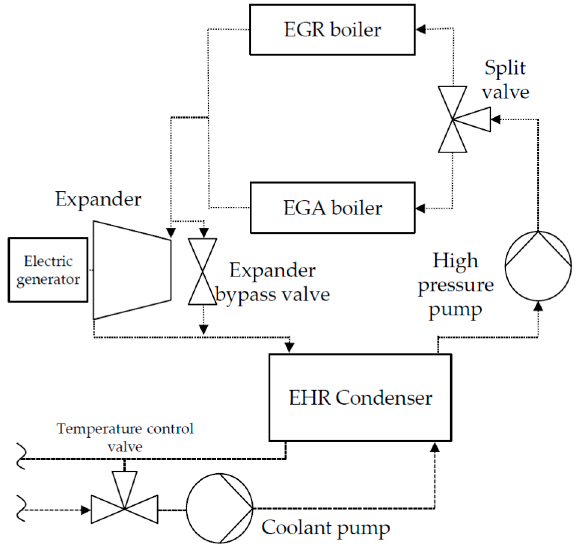
Figure 1. Parallel evaporator Rankine cycle. EGA: exhaust gas after-treatment; EGR: exhaust gas recirculation; and EHR: exhaust heat recovery. Table 1. Comparison of road average and steady state test bench boundary conditions, operating point 3. EGA: exhaust gas after-treatment; and EGR: exhaust gas